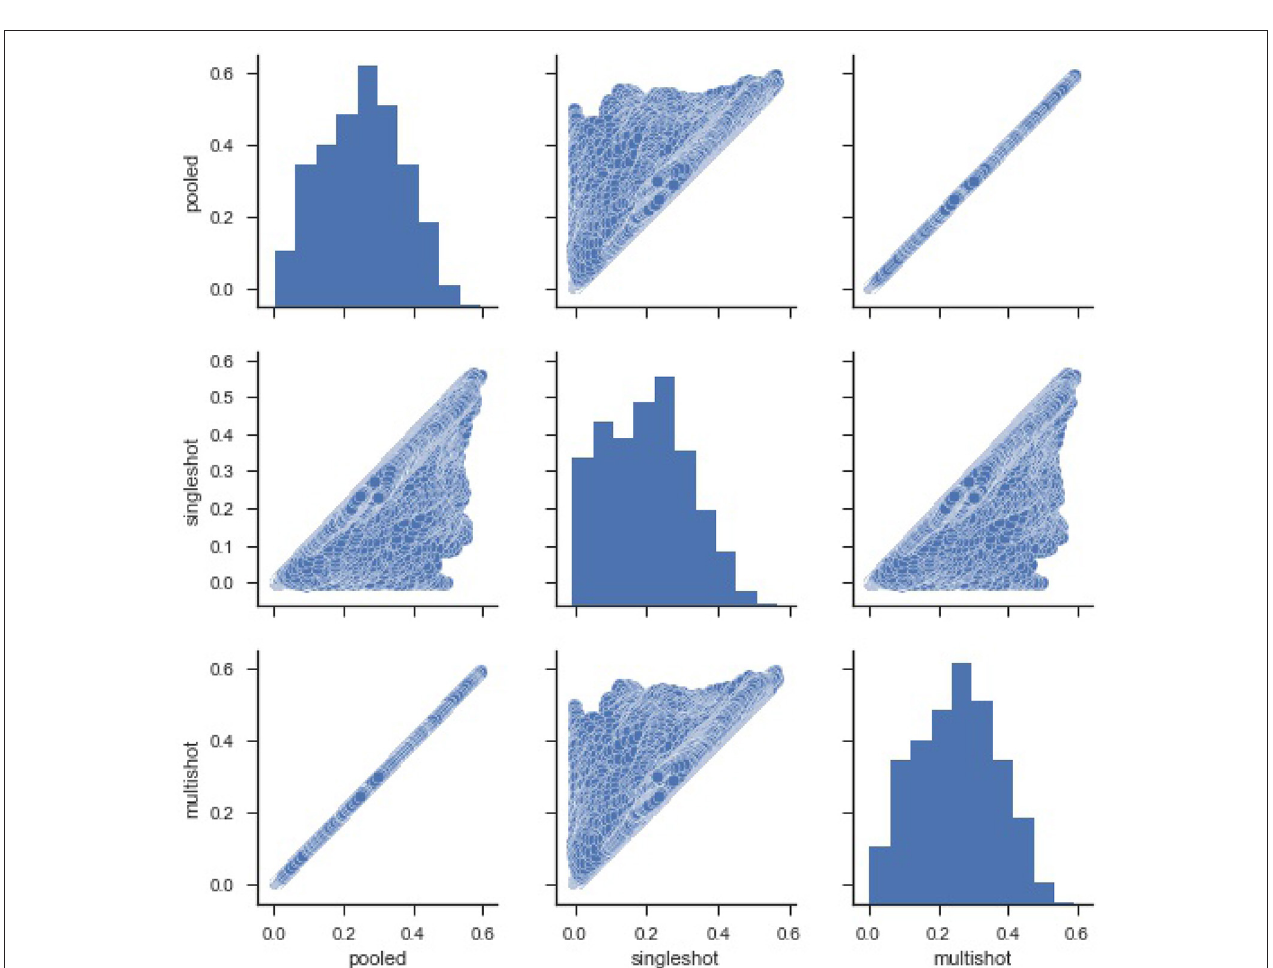
FIGURE 3 | Pairwise scatter plots of Coefficient of Determination R 2 from the three types of regression. It can be seen again that the R 2 values for the regressions from multi-shot regression and pooled regression are exactly equal. The R 2 values from single-shot regression are less than their corresponding values from pooled regression or multi-shot regression because the model being fit in single-shot has fewer covariates (Note, one of the limitations of the single-shot is that the site specific covariates could not be included as it introduces collinearity).